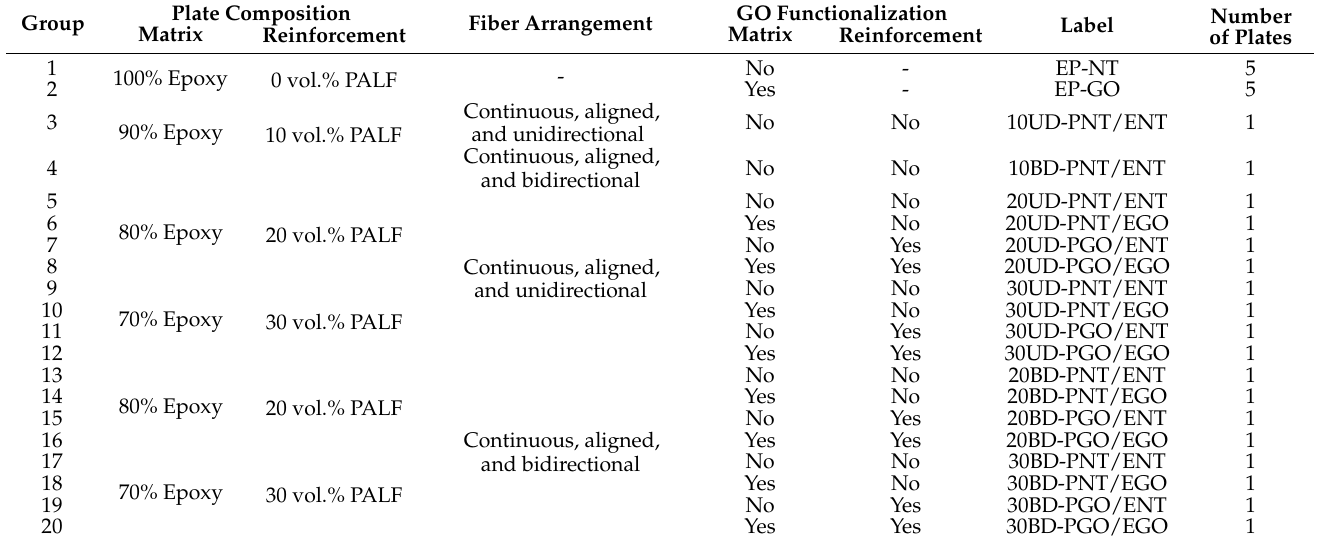
Table 1. Specification of the groups proposed for the ballistic test.